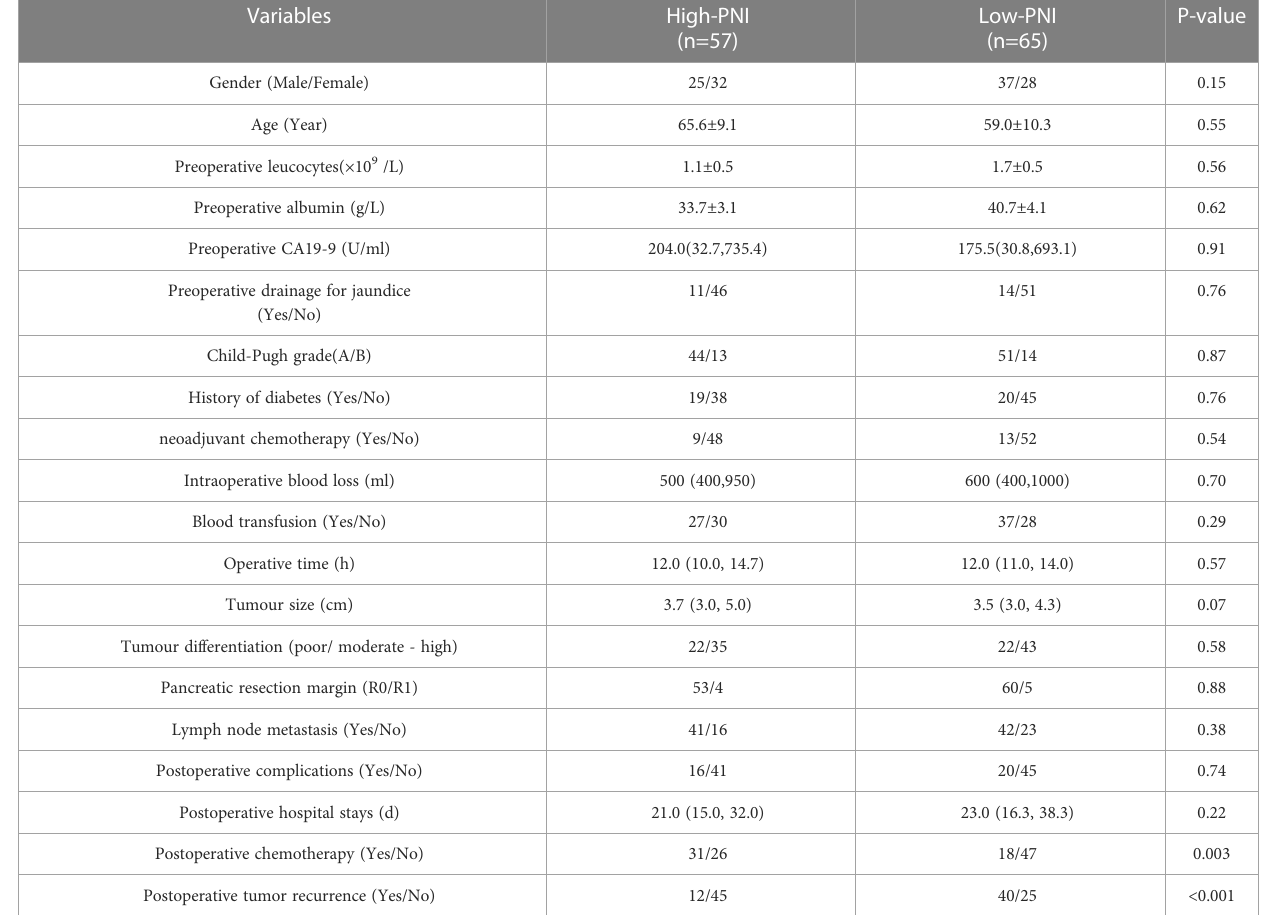
TABLE 1 Demographic and pathologic fi ndings in two